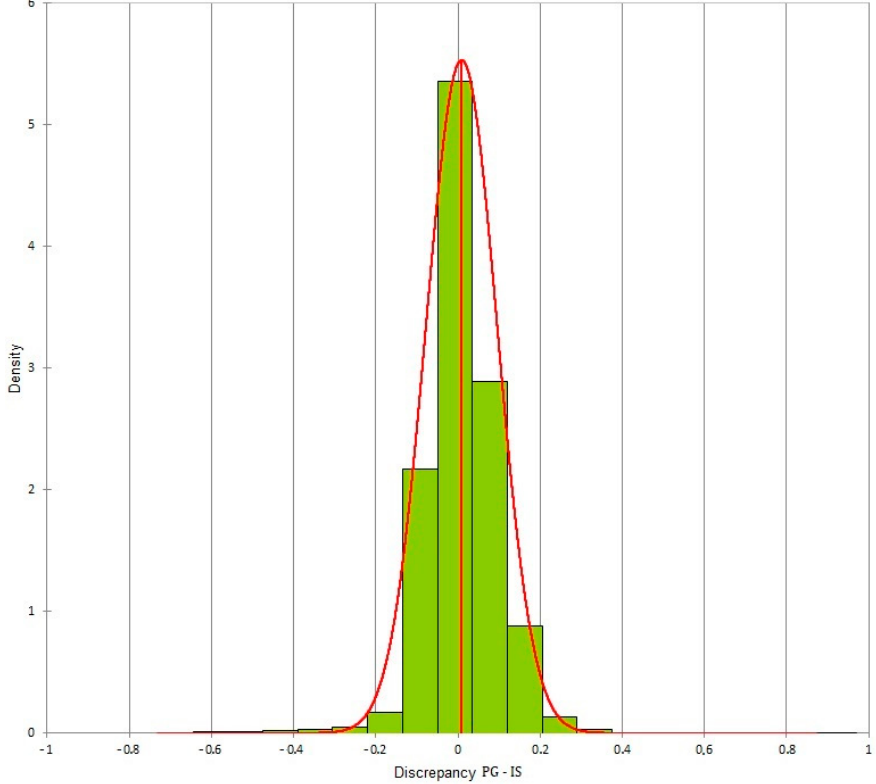
Figure 12. Histogram of the discrepancy between photogrammetry and intraoral scanner.